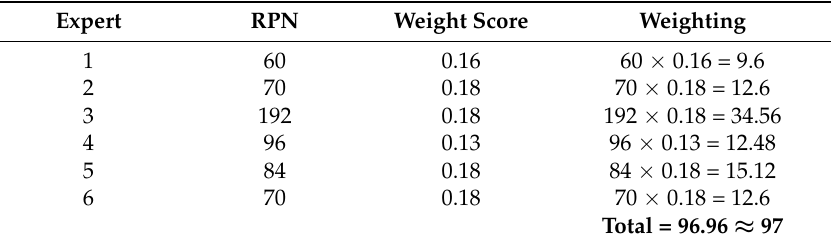
Table 10. Final aggregation for RPNs (example of the blind shear ram component).